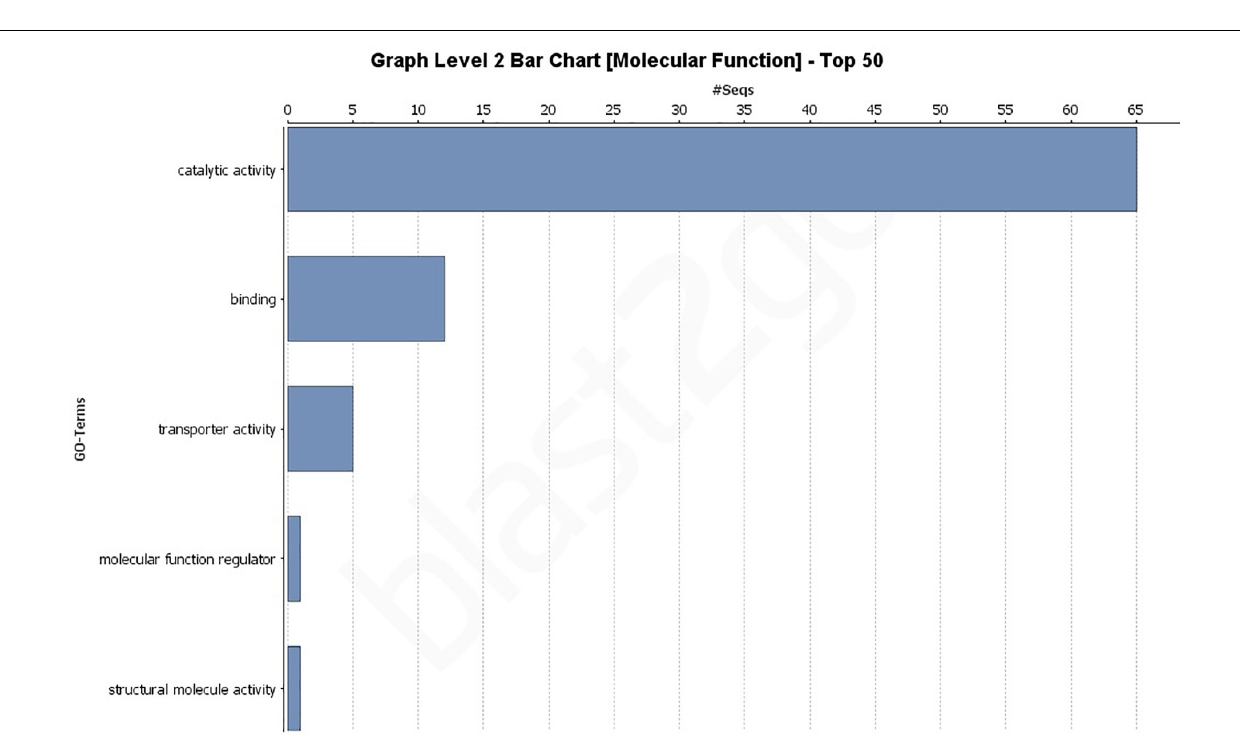
Frontiers in Microbiology |